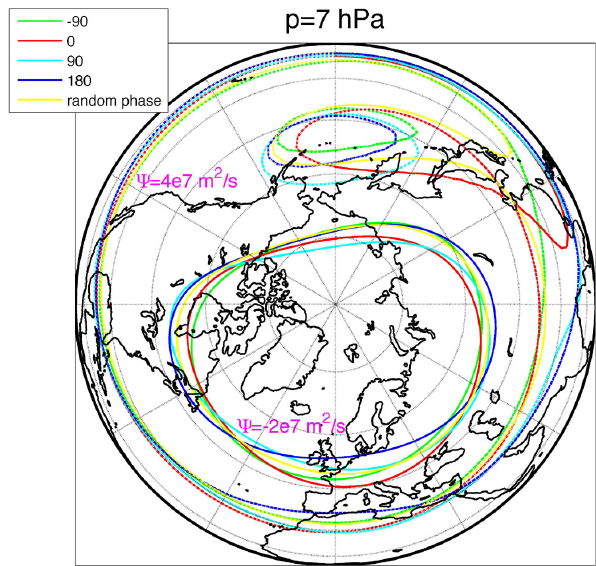
Fig. 6. Composites of the stream function for different phases of the 20-day oscillation above Bern (47.5 ◦ N, 7.5 ◦ E) based on ERA In- terim reanalysis data of the winter seasons 1979-2010. The solid streamlines ( 9 = − 2 × 10 7 m 2 s − 1 ) are near to the polar vortex edge. The dashed streamlines ( 9 = 4 × 10 7 m 2 s − 1 ) surround the Aleutian anticyclone. Phase 0 (red line) is calculated from a com- posite of stream functions when ozone minima (state 1) are present in the 20-day bandpass filtered ozone series at 7hPa above Bern from November to February. Phase − 90 ◦ refers to the composite of the stream function 5 days before state 1. Phase 90 ◦ refers to the composite of the stream function 5 days after state 1. Phase 180 ◦ refers to state 2 (maximal ozone at Bern) which is the composite of the stream function 10 days after state 1. Random phase refers to a composite with random timing marks between November and February in the time from 1979 to 2010. Random phase can be con- sidered as the mean state of the polar vortex. The legend is valid for both solid and dashed